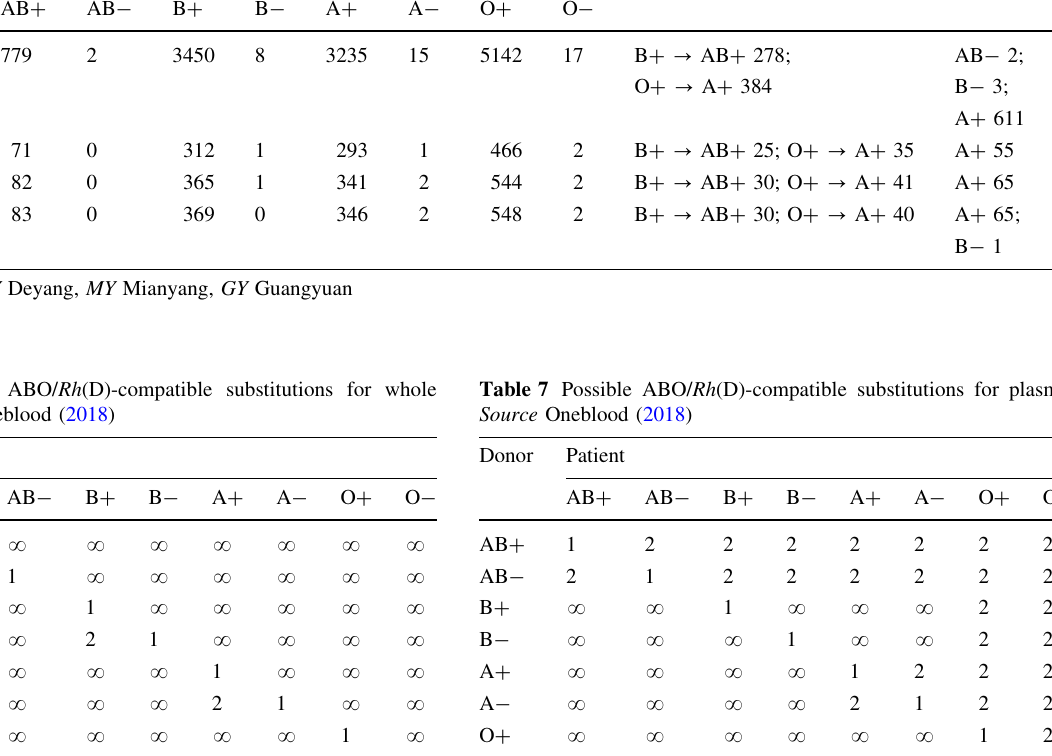
Table 5 Optimal emergency blood allocation scheme for the studied case after the Wenchuan Earthquake ( d ¼ 5 % ) Blood Banks a Homotype allocations (U)